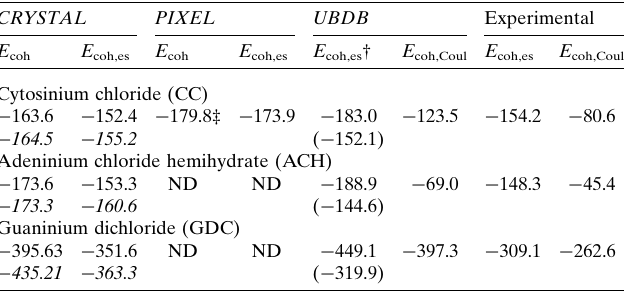
Table 5 Cohesive energies ( E coh ; kcal mol (cid:4) 1 ) and electrostatic contributions to the cohesive energies ( E coh,es , E coh,Coul ; kcal mol (cid:4) 1 ) for the CC, ACH and GDC crystals computed from different methods for experimental geometries and for optimized theoretical geometries (values in italics). Energies are given per ionic pair (including halves of water molecules in the case of ACH). ND denotes values that were not determined due to limitations of the